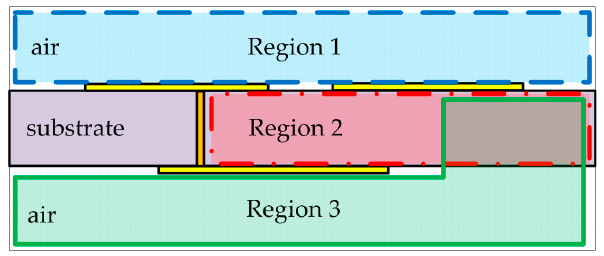
Figure 3. Three-regions of a cross-section of the proposed microstrip-to-slotline transition.